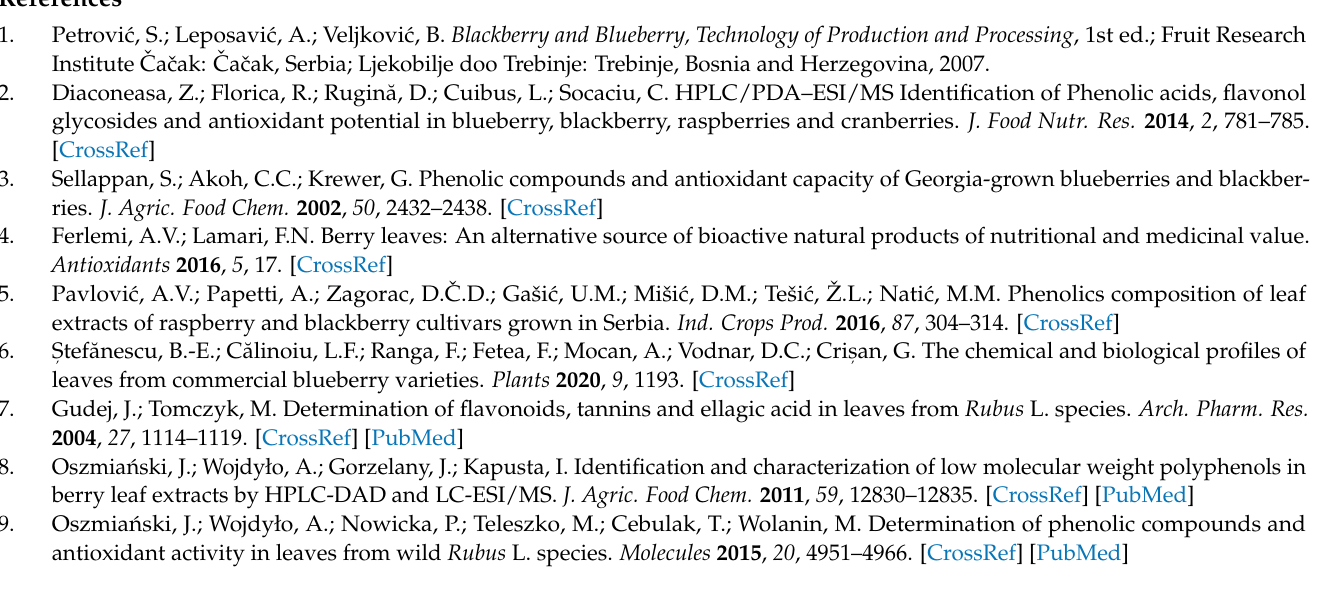
Table S2: The list of quantified phenolic compounds, with retention times (min), SRM transitions and specified collision energies; Figure S1: Axillary shoot proliferation of blackberry ‘ ˇCaˇcanska Bestrna’; Figure S2. Axillary shoot proliferation of blueberry